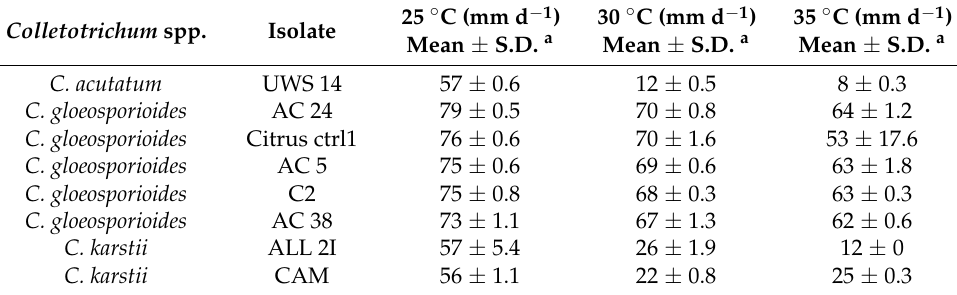
Figure 2. Morphology of 6-day-old colonies of Colletotrichum gloeosporioides (AC24, AC38, AC5, C2 and Citrus ctrl1), C. acutatum (UWS 149) and C. karstii (ALL 2I and CAM) grown on potato-dextrose-agar at 25 °C in the dark. Table 3. Mean radial growth rates of colonies of Colletotrichum spp., isolates on PDA at three different temperatures, as determined after 7 d of